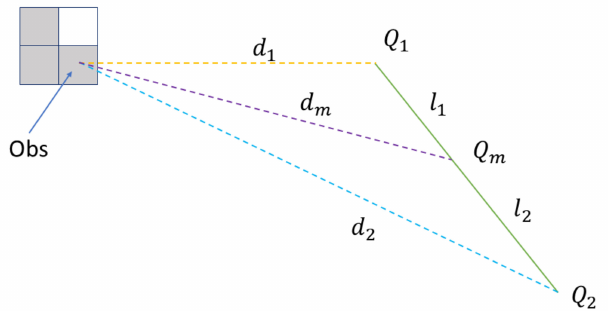
Figure 6. Schematic diagram of path safety derivation. Q 1 and Q 2 are two path points, and Q m is any point on the path.